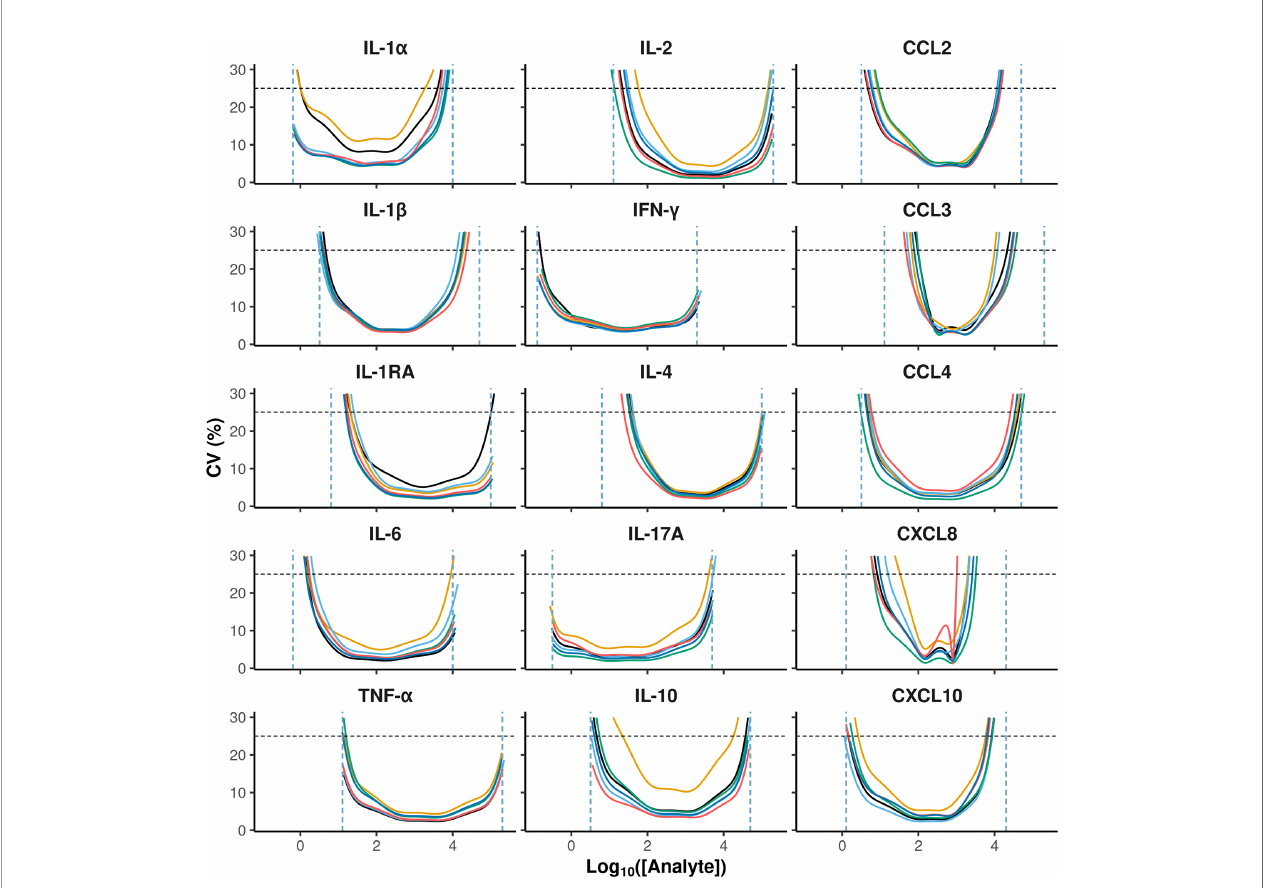
FIGURE 3 | Coef fi cient of variation of MFI estimates as a function of cytokine concentrations. The x and y-axis represent analyte concentrations in Log10 and the coef fi cient of variation in percentage, respectively. The values of 6 separate plates are represented in different colors: horizontal black dashed lines indicate the 25% threshold that was used to de fi ne the reliable lower and upper quanti fi cation limits represented by the vertical blue dashed lines.